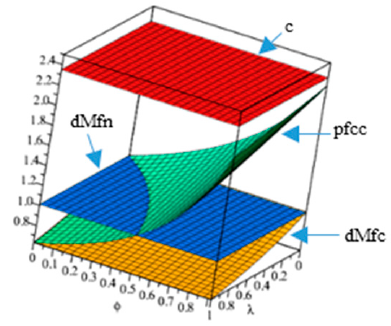
Figure 3. Effects of fairness concerns and profit-sharing on sales effort degree.